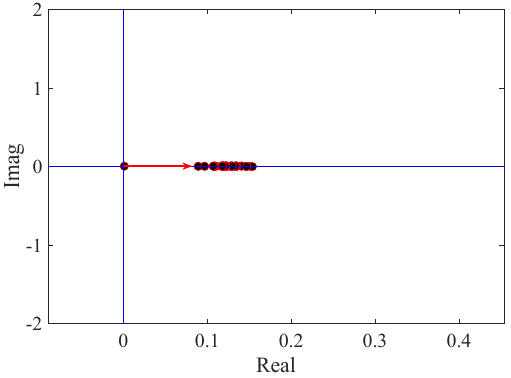
Figure 5. Nodal voltage mode shape of 77.1 Hz resonance mode. Table 5. Elements in participation factor matrix of 77.1 Hz resonance mode (descending order).